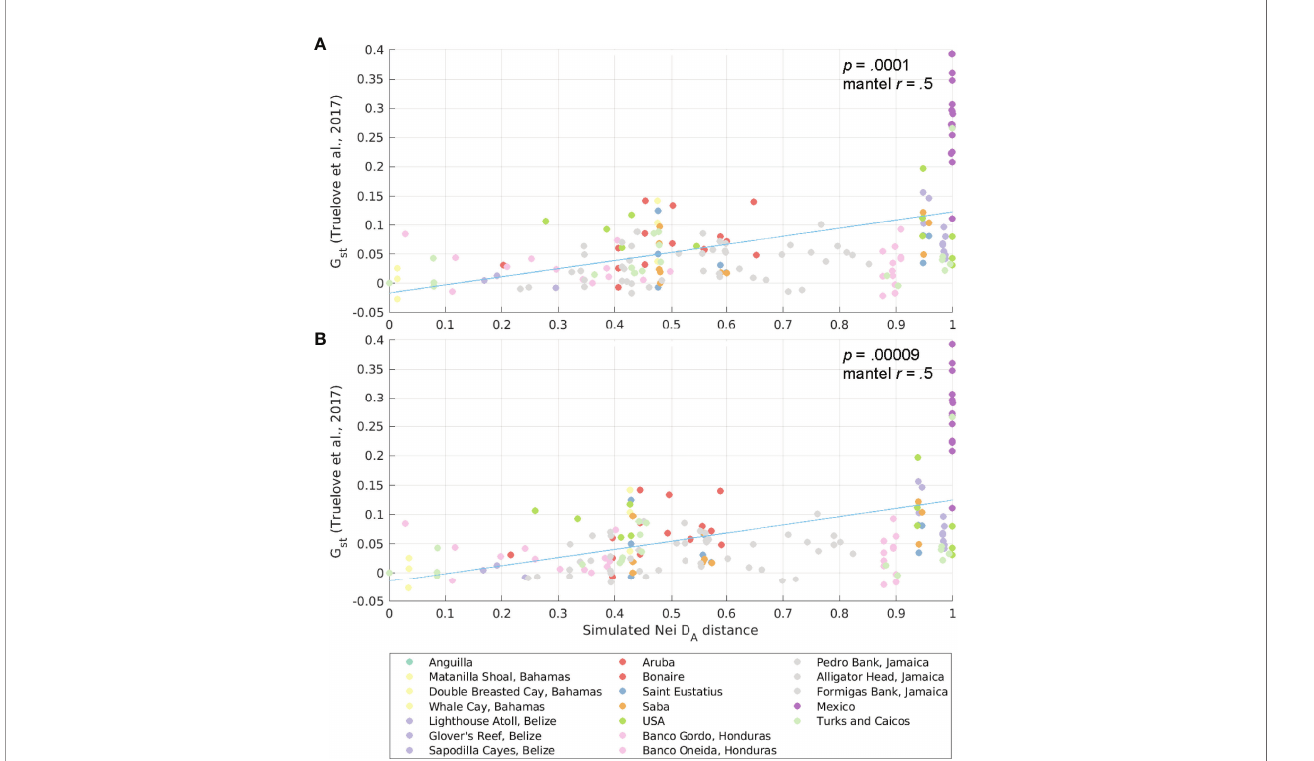
FIGURE 9 | Scatter plot of Nei ’ s D A genetic distance (from simulations) and pairwise genetic differentiation (linearized G ST , based on G ST from Truelove et al., 2017) for Aliger gigas . The simulated Nei ’ s D A genetic distance is an average of the genetic distances obtained with the HYCOM and GLORYS12v1 velocities for (A) 50 generations and (B) 100 generations. The trend line is shown in blue, and dots are color-coded by the sampling jurisdiction (or the source jurisdiction for the larval dispersal